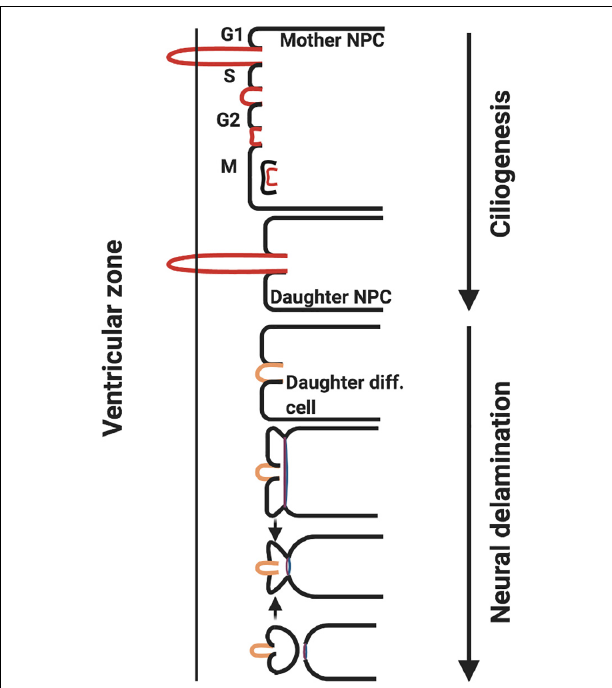
FIGURE 6 | ZIKV causes ciliopathy and forces premature neurogenesis. During asymmetric division of apical NPCs, the daughter cell that reforms the primary cilia remains attached to the ventricular surface whereas the other daughter cell that does not undergo ciliogenesis delaminates from the ventricular surface and differentiates. ZIKV NS5 protein interacts with cellular proteins at the base of the primary cilia in NPCs causing an atypical ciliopathy and premature neuron delamination (adapted from Saade et al., 2020, created with